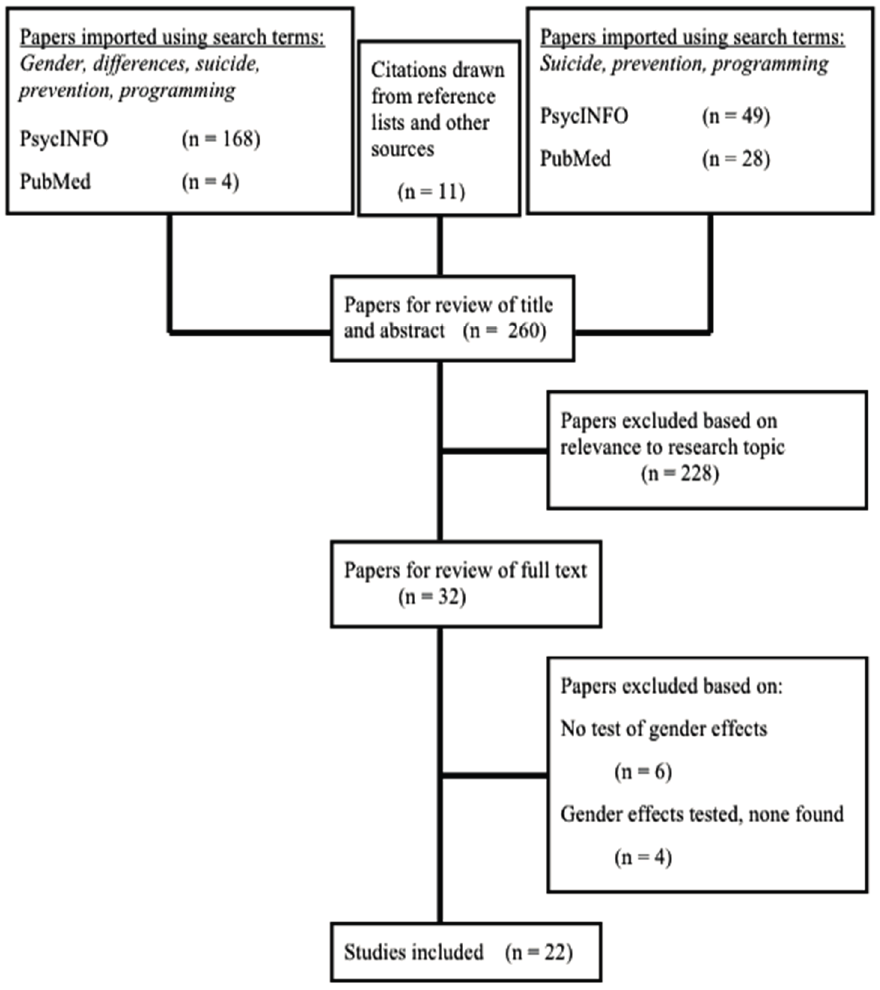
Figure 1. Flowchart of literature review